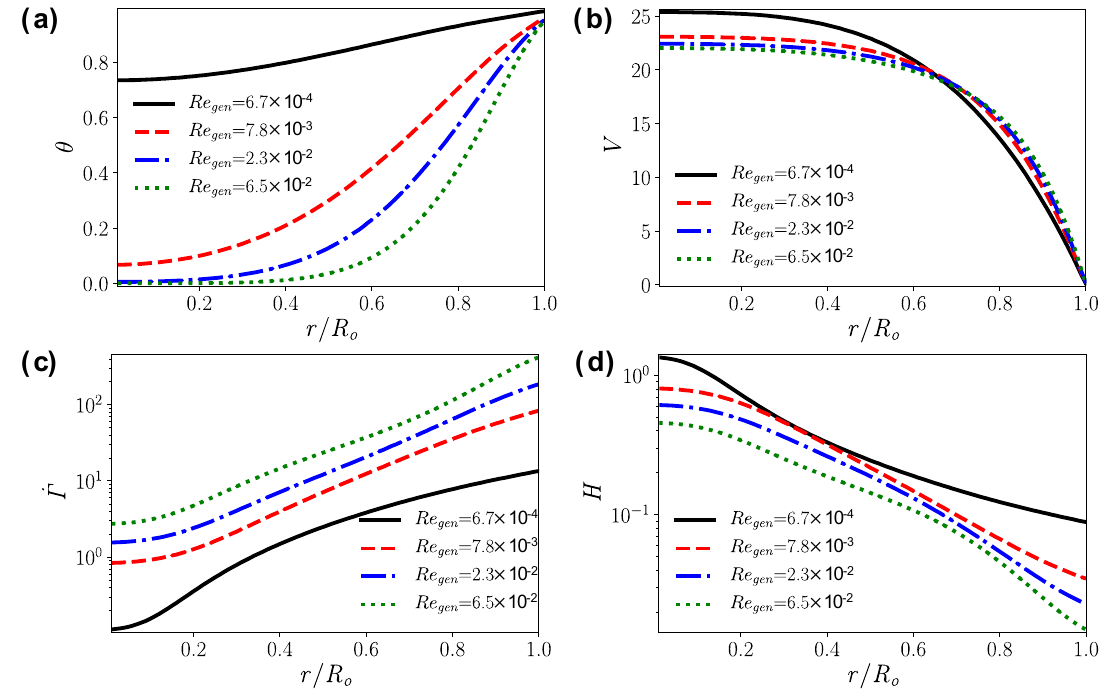
Figure 11. The dimensionless ( a ) temperature, ( b ) velocity, ( c ) shear rate and ( d ) apparent viscosity profiles in the radial direction for various Re gen . The inlet mean velocity is used as the reference velocity. The mean shear rate and the mean apparent viscosity when θ w = 1 and Re gen = 2.3 × 10 − 2 are used as reference values.